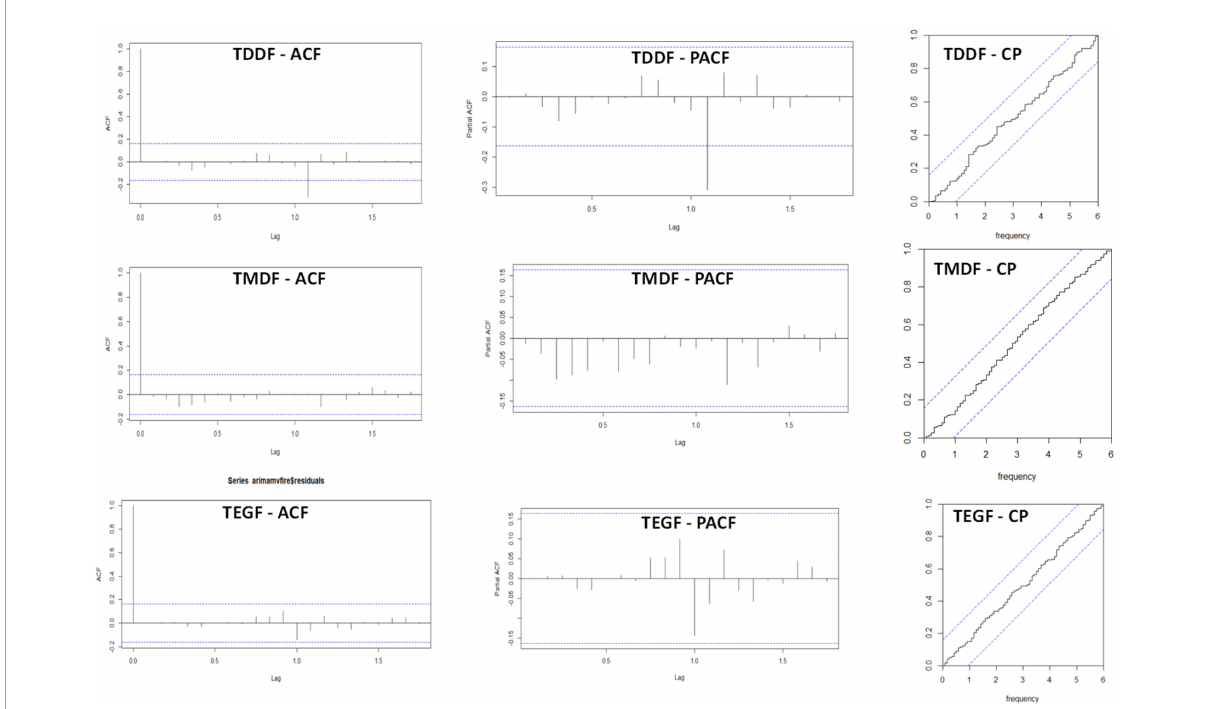
FIGURE8 Residual Autocorrelation function (ACF), residual partial autocorrelation function (PACF) and cumulative periodogram (CP) of residual for ARIMA model with regressors (i.e., temperature and dry days) for Tropical Dry Deciduous Forests (TDDF) Tropical Moist Deciduous Forests (TMDF) and Tropical Evergreen Forests (TEGF).